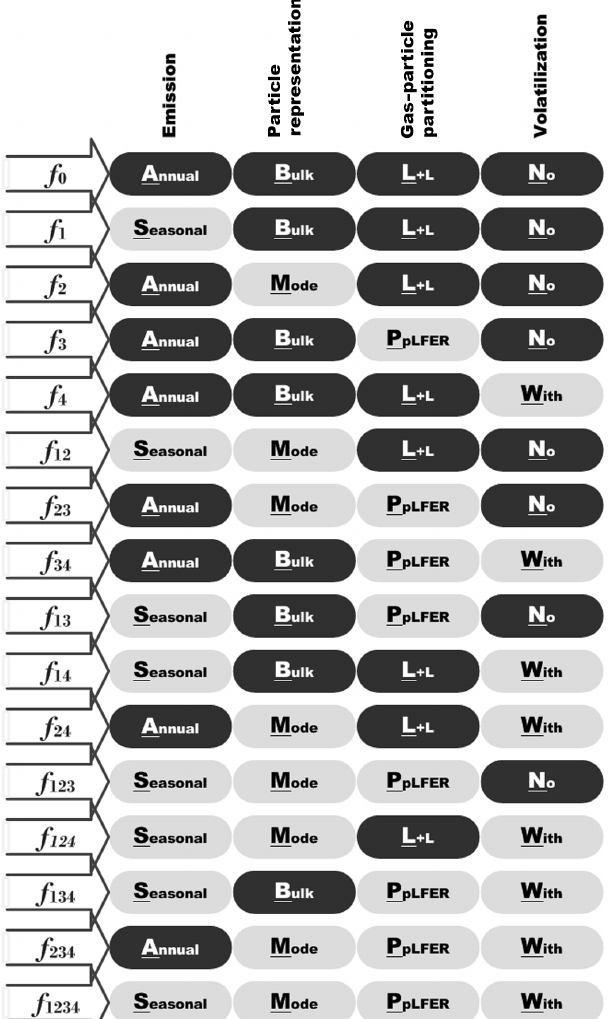
effect is more pronounced in the middle latitudes rather than in high latitudes (Supplement Sect. SVII, Fig.